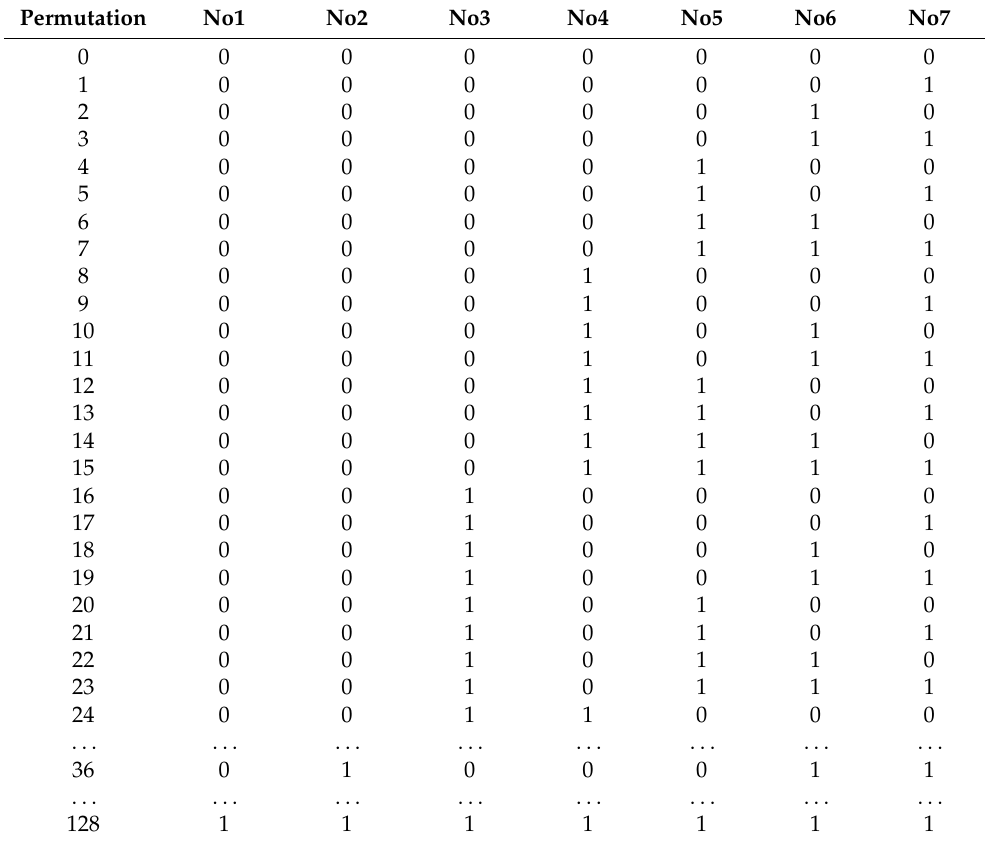
Table 3. Binary permutation distribution of the HFO tanks.